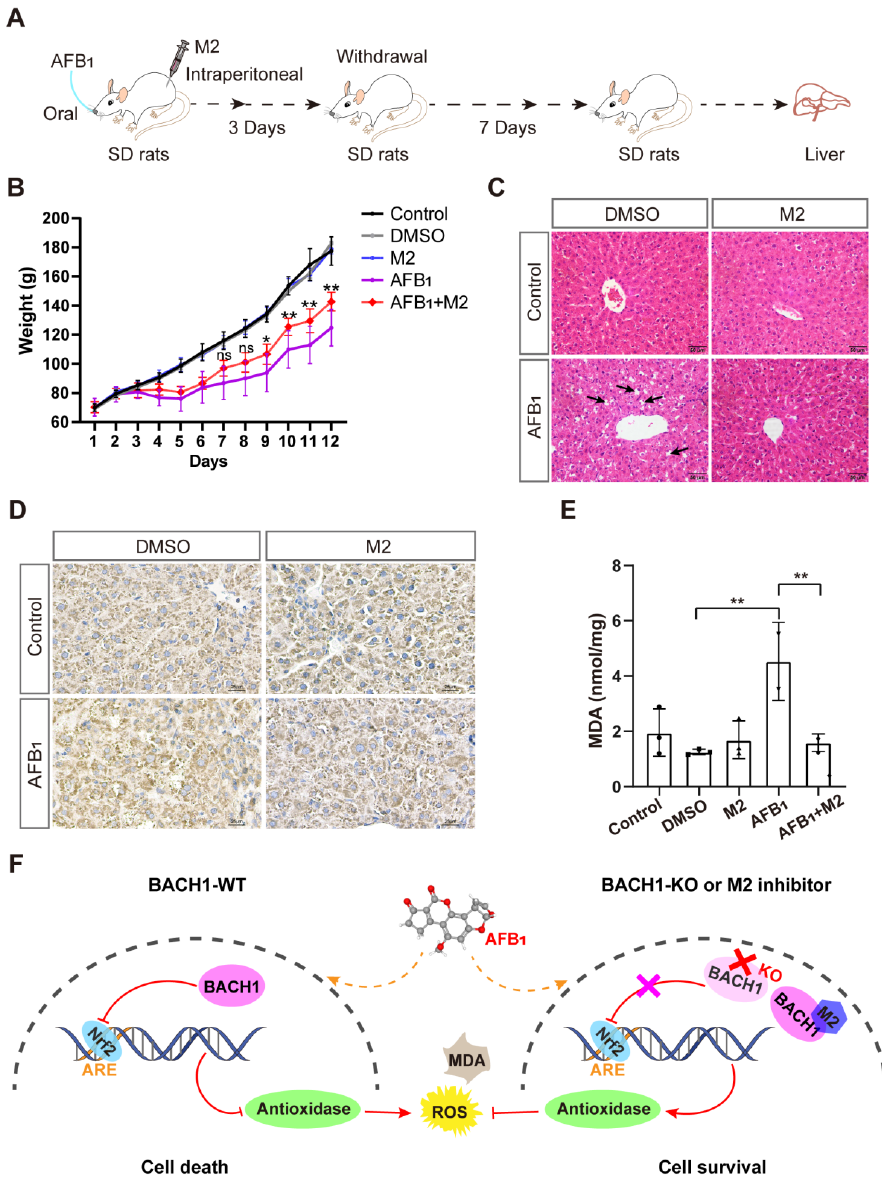
Figure 5. Liver damage from aflatoxin B 1 is significantly lower in M2-treated rats. ( A ) Schematic of M2 treatment of AFB 1 -induced SD rats. ( B ) Body weights of SD rats during AFB 1 exposure with and without M2 treatment. ( C ) Liver histopathology of AFB 1 -exposed rats and control group. The spe- cific inflammatory cell infiltration is indicated with an arrow. Scale bar, 50 μ m. ( D ) Representative light microscopy images of immunohistochemical staining for AFB 1 -DNA adducts in liver tissues with and without M2 treatment. Scale bar, 25 μ m. ( E ) MDA levels in liver tissues with and without